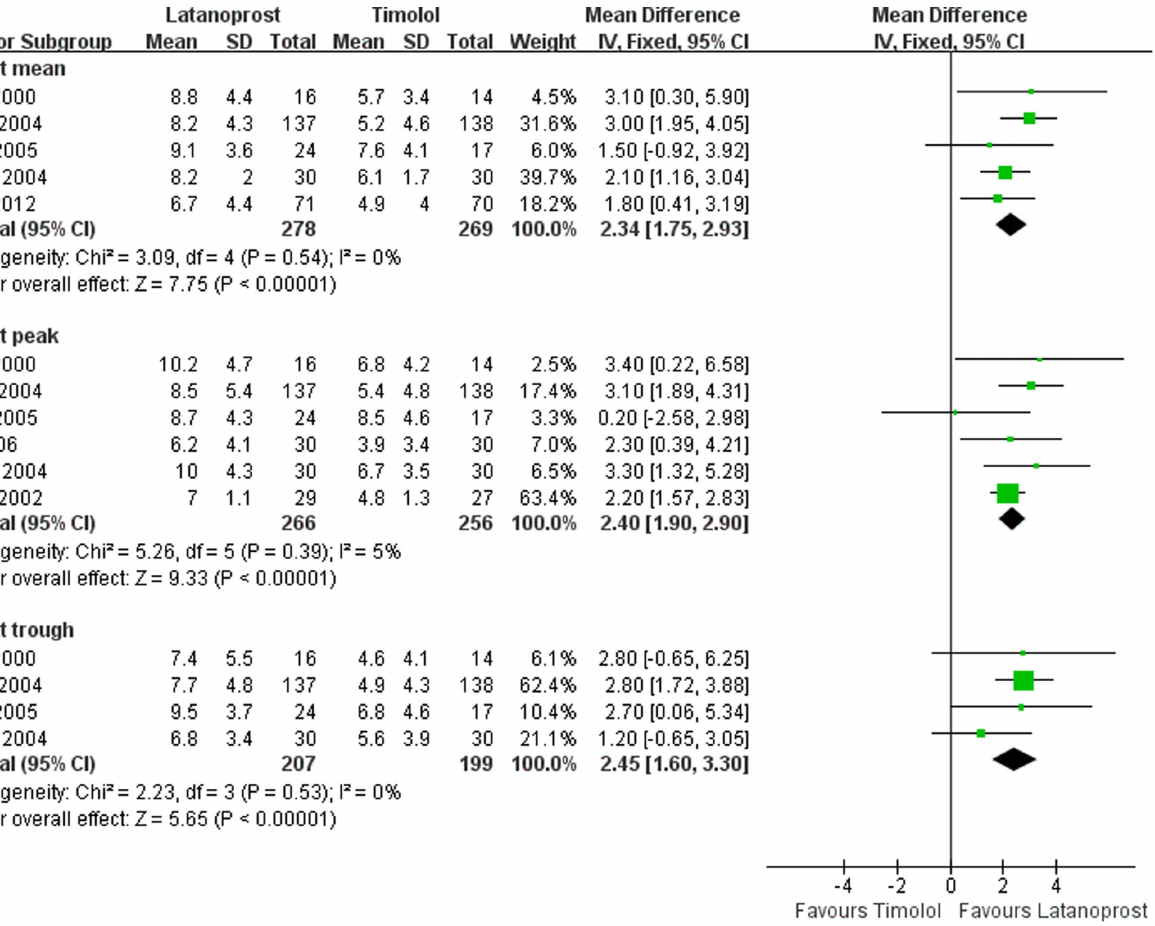
Figure 4. Comparison of Absolute IOP reductions between latanoprost and timolol. doi:10.1371/journal.pone.0096852.g004 (2) Systemic Adverse Events. More systemic adverse effects were observed in patients treated with timolol than latano- prost (OR =0.46, 95% CI, 0.25 , 0.84, P= 0.01). The risk for